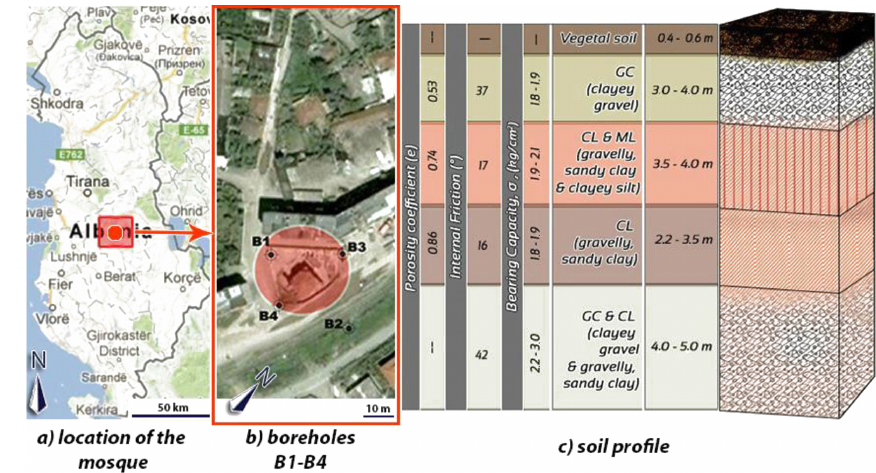
Figure 1. Location of the mosque (a) , boreholes B1–B4 (b) and soil profile under the mosque (c) .